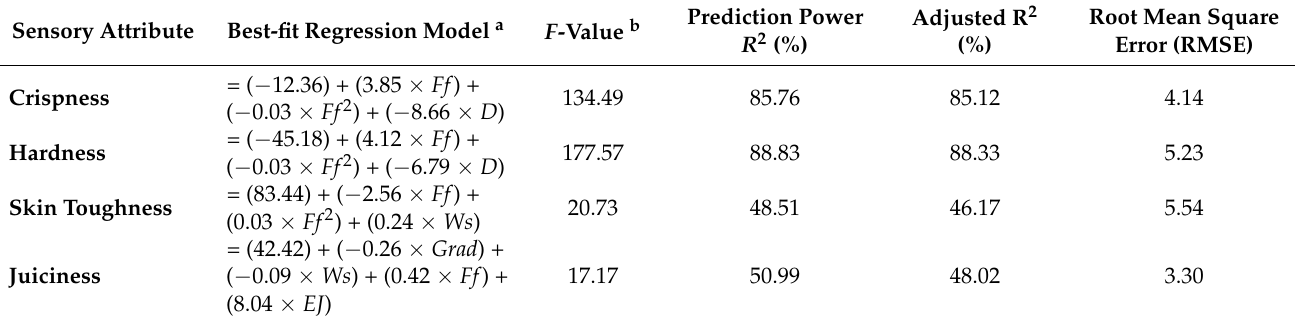
Table 4. Best-fit regression models for predicting sensory attributes from determination with the TA.XT plus Texture Analyzer. Models were developed using mean values ( n =